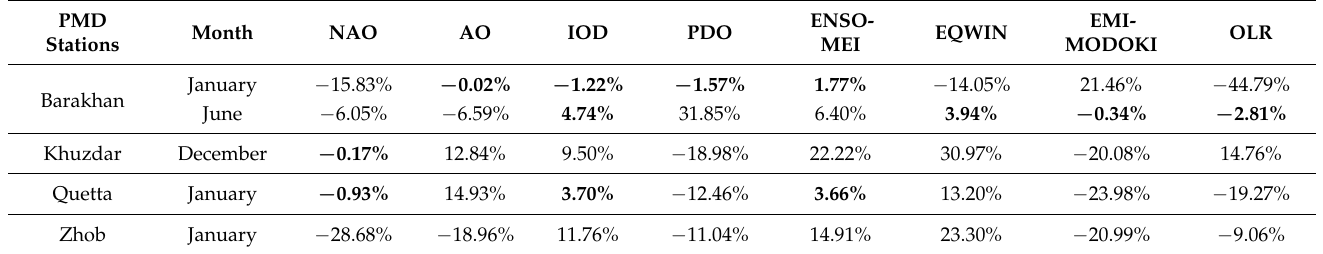
Table 4. Correlation of precipitation of climatic indices (individual stations) with significant trends and noteworthy Theil–Sen